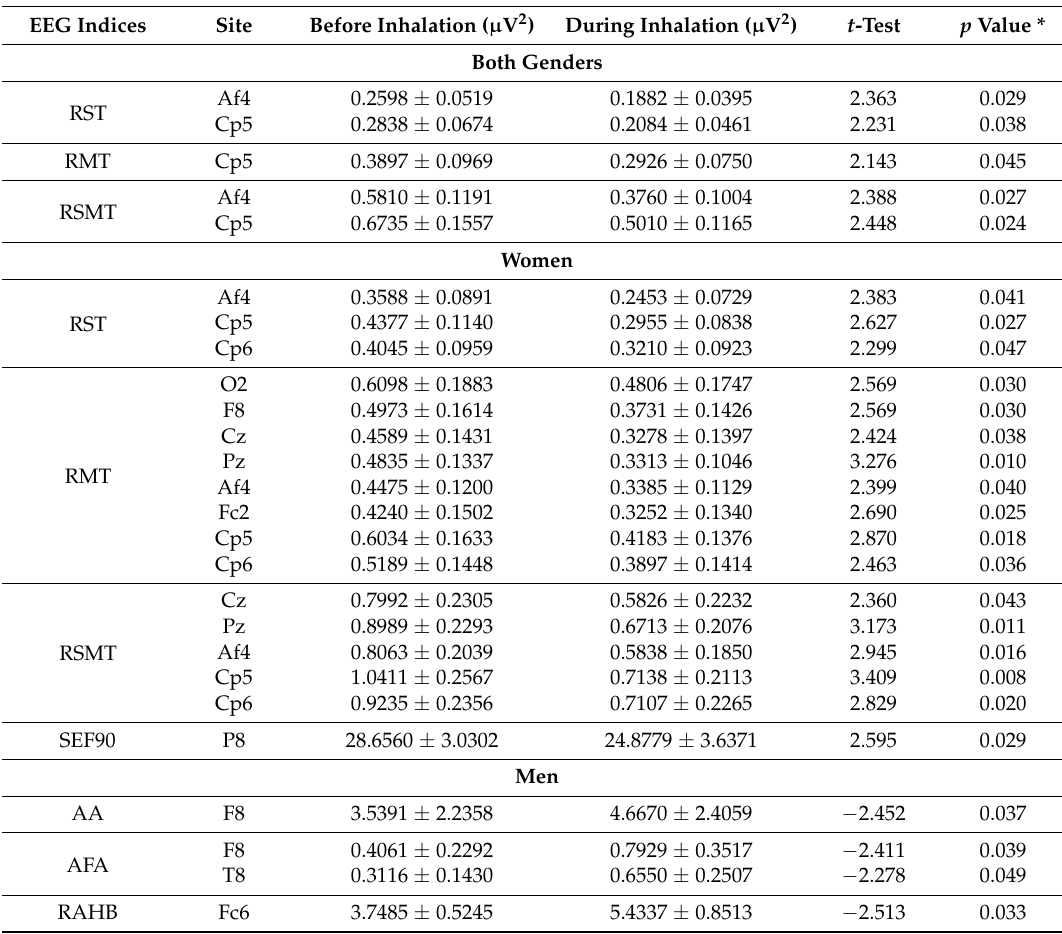
Table 3. Significant changes of EEG power spectra during the inhalation of 2-methylisoborneol in both genders. EEG